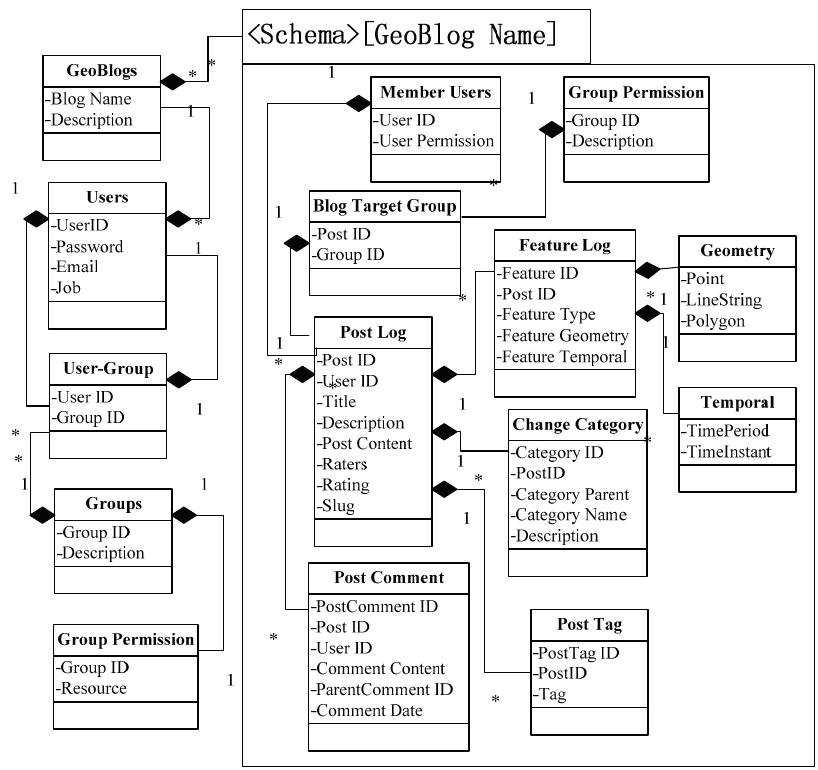
Figure 7. The database schema for the tagging